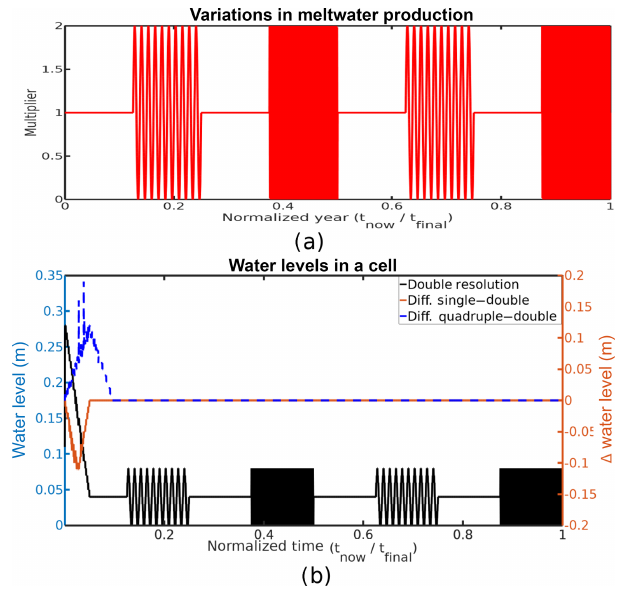
Figure 4. Time series analysis of basal water level response to time- varying meltwater production, showing that the dynamic time step- ping of the model is capable of providing stable, realistic results under sudden